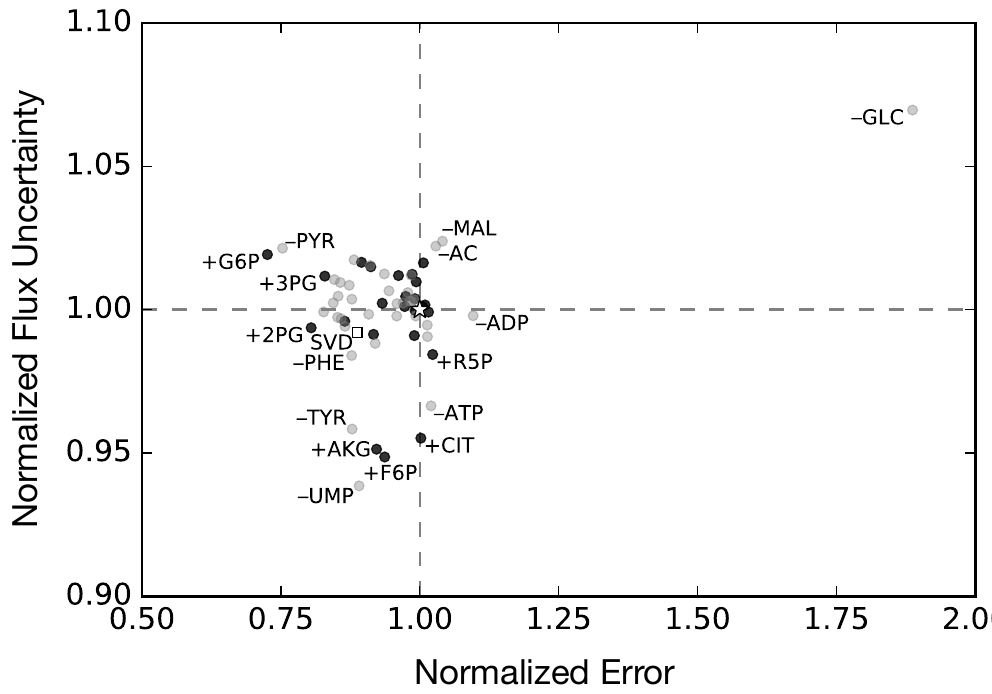
Figure 5. Flux uncertainty versus metabolite prediction error against synthetic data, normalized to the base case (white star), for exclusion (gray) and inclusion (black) metabolite constraint sets. The performance of the singular value decomposition (SVD)-determined metabolite constraint set is shown by the white